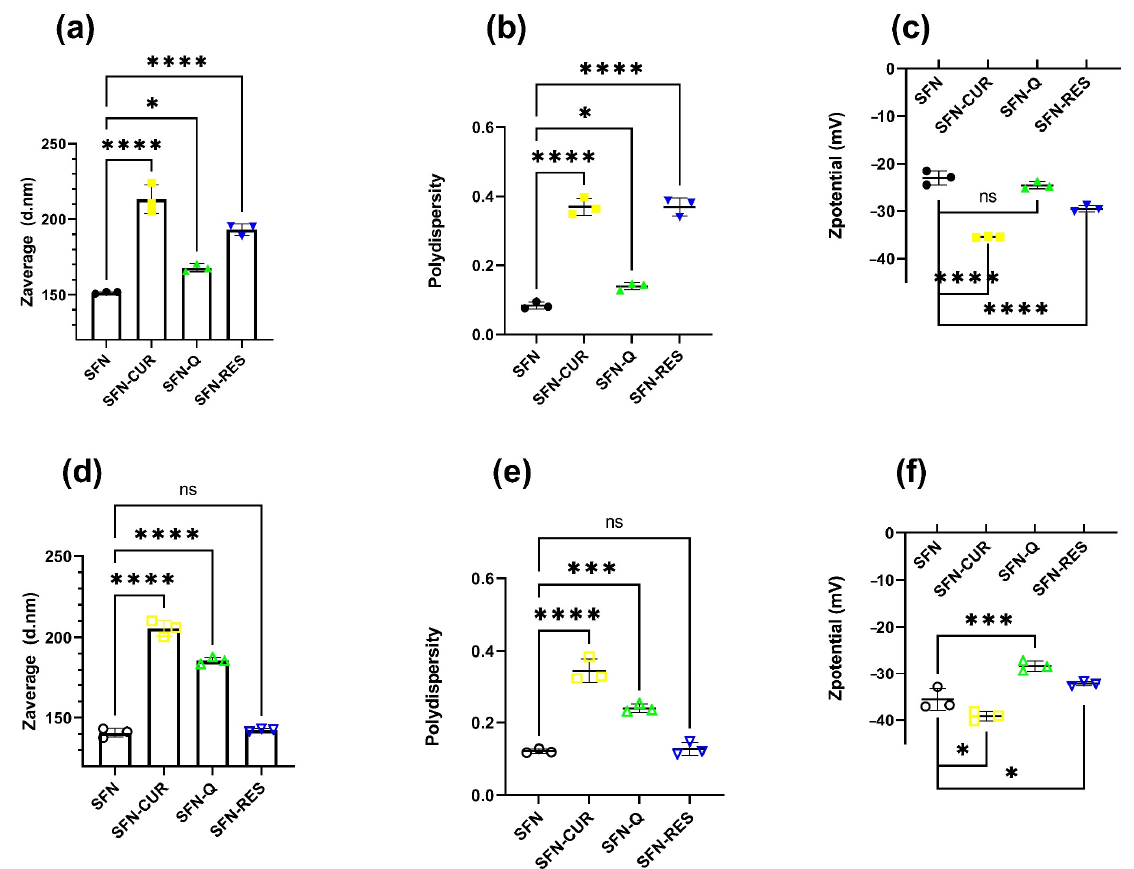
Figure 4. Hydrodynamic parameters of the aqueous suspensions of the SFN-PPh as prepared ( a – c ) and after the sterilization with γ -irradiation (2.5 kGy) ( d – f ). p -values were calculated using the two-way ANOVA test (considering p < 0.05 significant), followed by a Dunnet’s post hoc analysis, and are represented as * p < 0.05; *** p < 0.001; **** p < 0.0001. Thus, while SFN-CUR showed a noticeable increase in Z ave and PdI in both cases with respect to the unloaded SFN ( p < 0.0001, Dunnett), the effect on the ζ value was less intense in the irradiated samples ( p < 0.05, Dunnett) than the non-treated ( p < 0.0001, Dunnett),